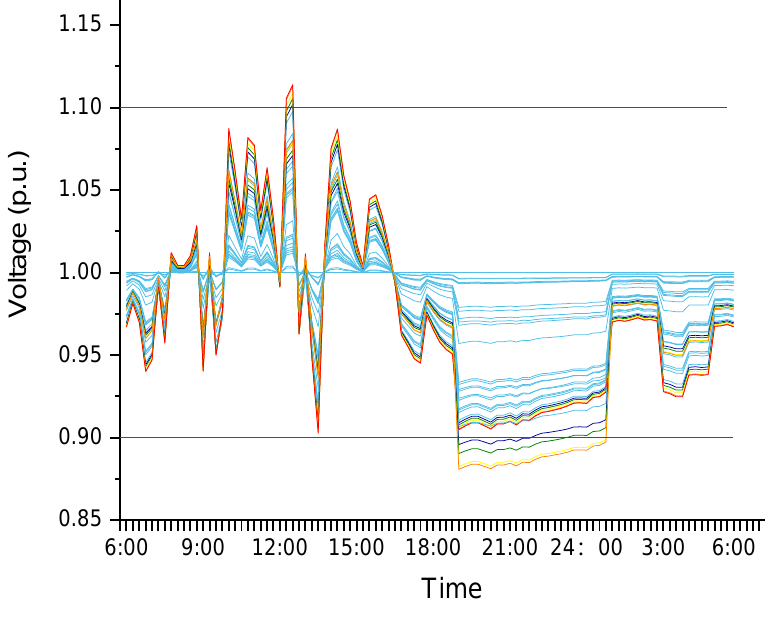
Figure 5. Voltage of 32-node of Case 1.